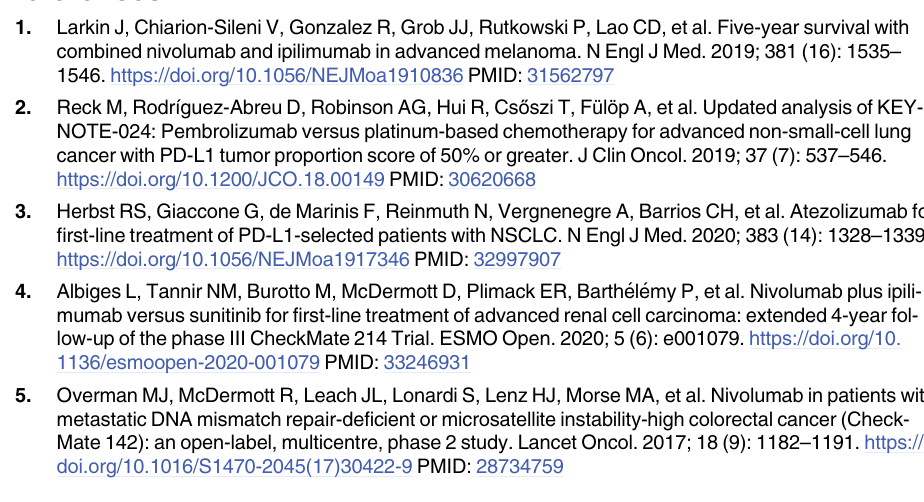
S1 Table. Summary of the 7 cases with initial multiple irAEs among the 42 cases of ICI